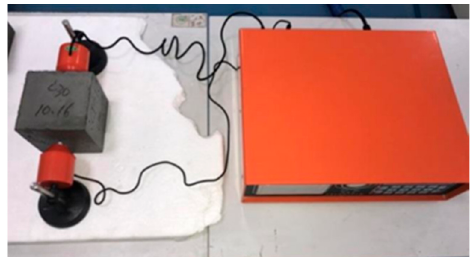
Figure 3. Measuring the dynamic modulus of elasticity.